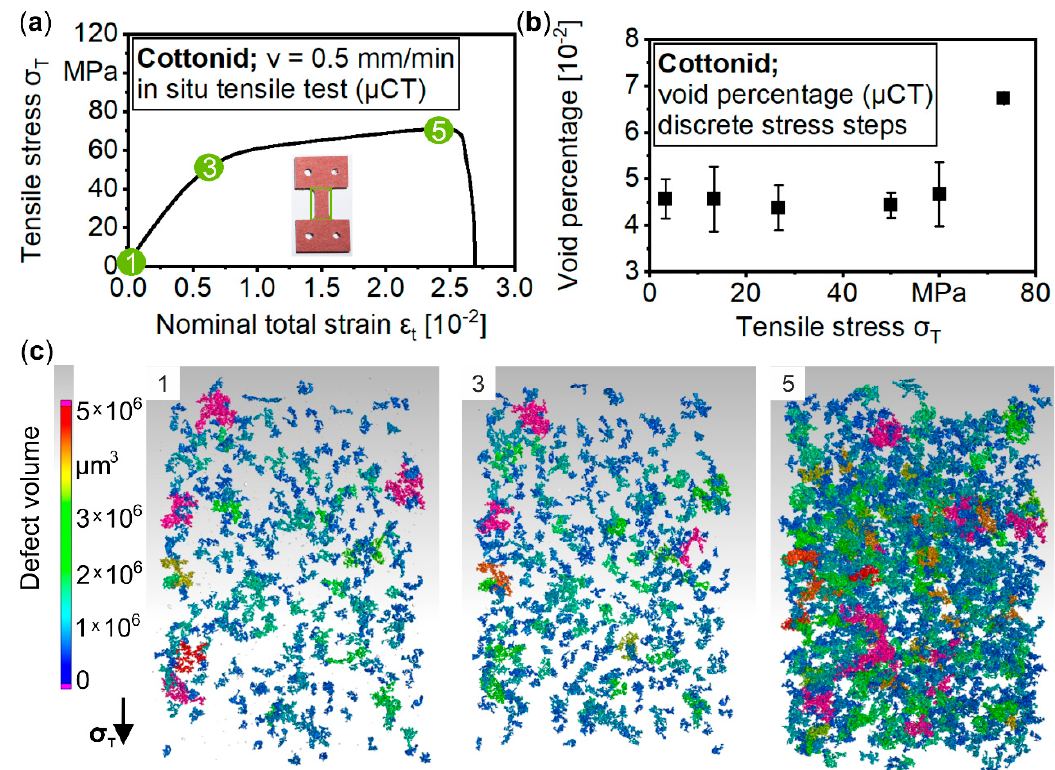
Figure 9. In situ tensile test in µ CT: ( a ) significant points in stress–strain curve for performing µ CT scans; ( b ) percentage development of void volume and ( c ) visualization of void volume in the specimen’s gauge length for discrete tensile load steps.